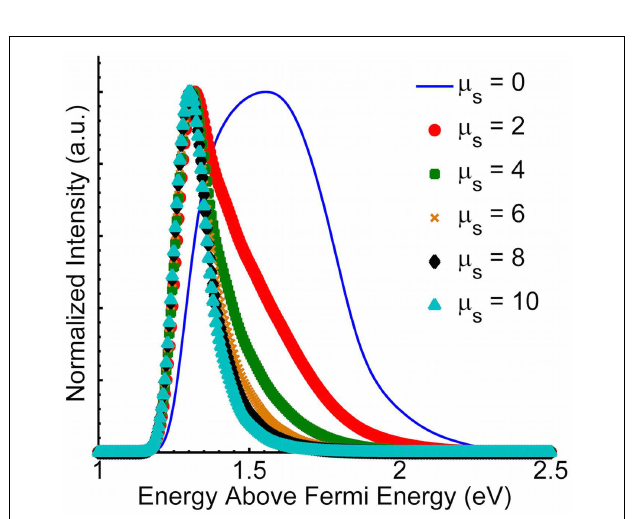
FIGURE 6 | REM PEED for varying µ s with φ = 1.5eV, T = 500K, E F = 5.0eV, and σ = 66meV .